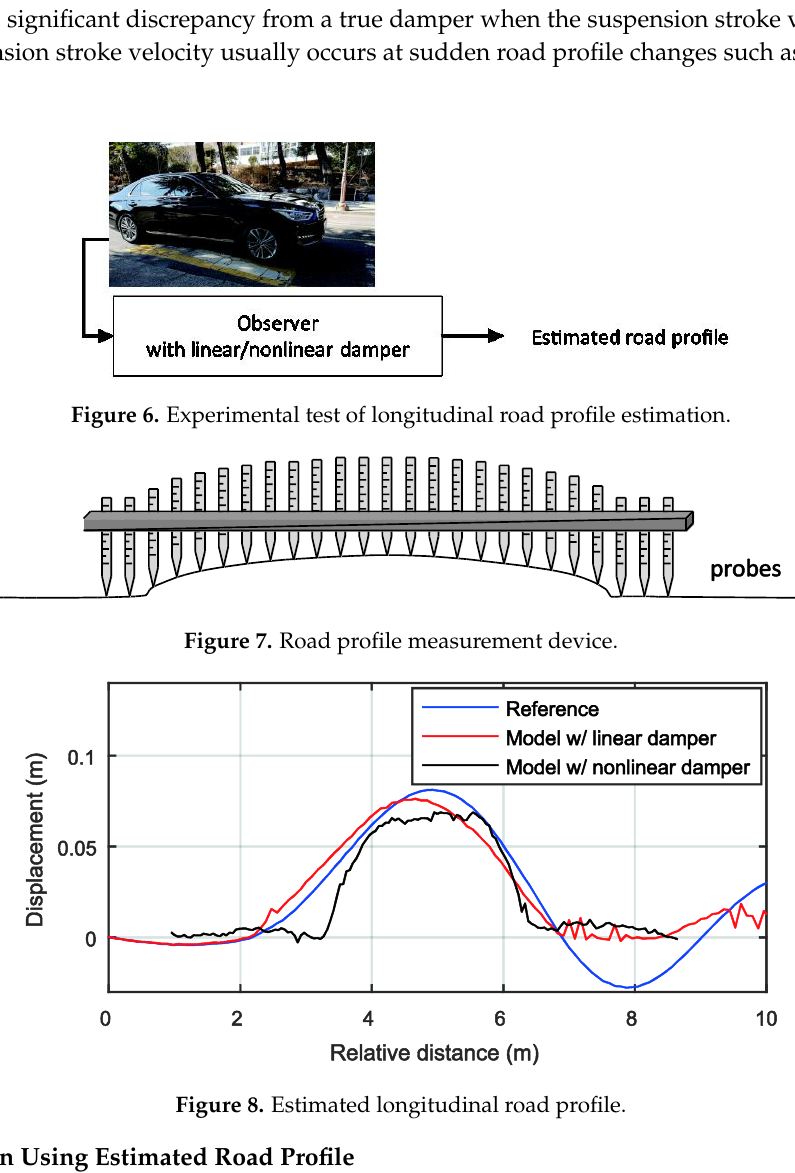
Figure 8. Estimated longitudinal road profile.